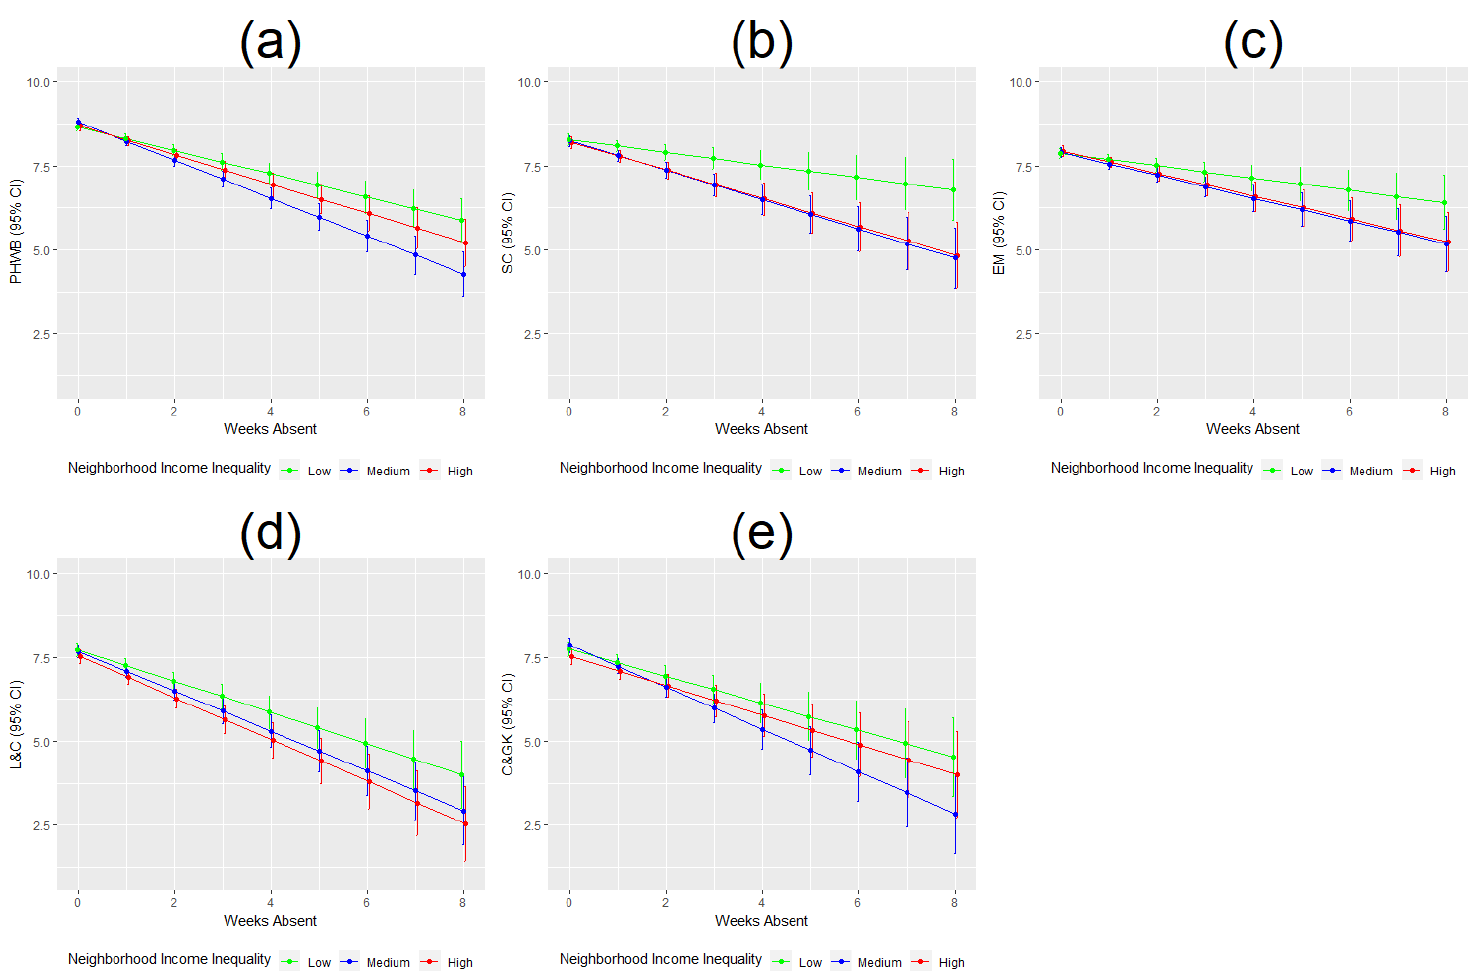
Figure 3. Predicted EDI scores by duration of school absence and neighborhood income inequality. ( a – e ) show the relationship between duration of school absence in weeks and predicted EDI domain scores and 95% confidence intervals are di ff erent for neighborhoods of low, medium and high income inequality. PHWB: physical health and well-being; SC: social competence; EM: emotional maturity; L & C: language and cognitive development; C & GK: communication and general knowledge.